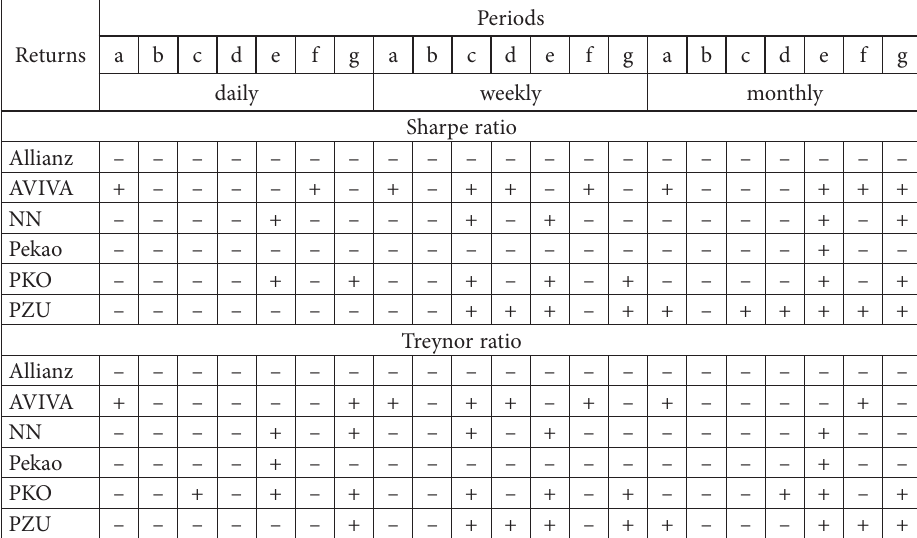
Table 19. Differences in efficiency ratios evaluated for FIO and OFE (source: own calculations on the basis of Tables 13–18 and Witkowska (2016, pp. 119-138)